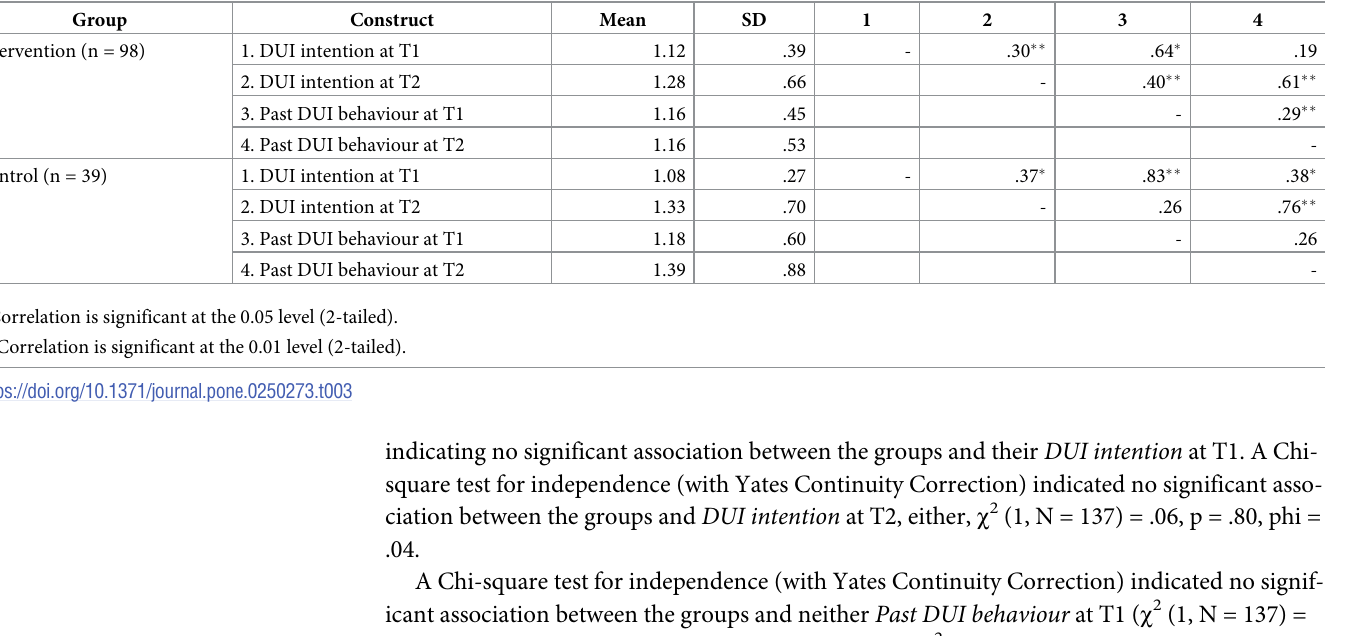
Table 3. Frequencies, means, standard deviations and bivariate Spearman correlations (n = 137).